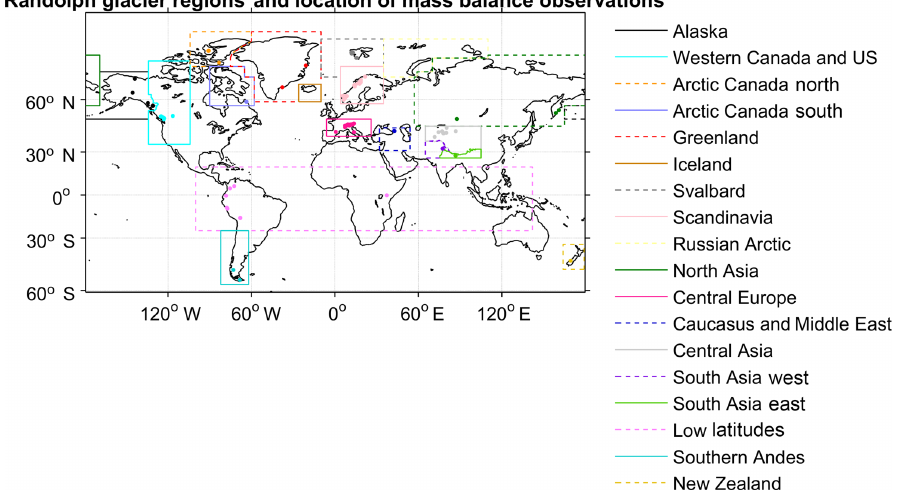
Figure 2. The location of mass balance profile observation glaciers from the World Glacier Monitoring Service and the Randolph Glacier Inventory regions (version 6.0). Table 2. Best parameter sets for each RGI6 region. The regions are ranked from the lowest to the highest RMSE. There are no observed profiles for Iceland and the Russian Arctic, so the global mean parameter values are used (bold) for the future